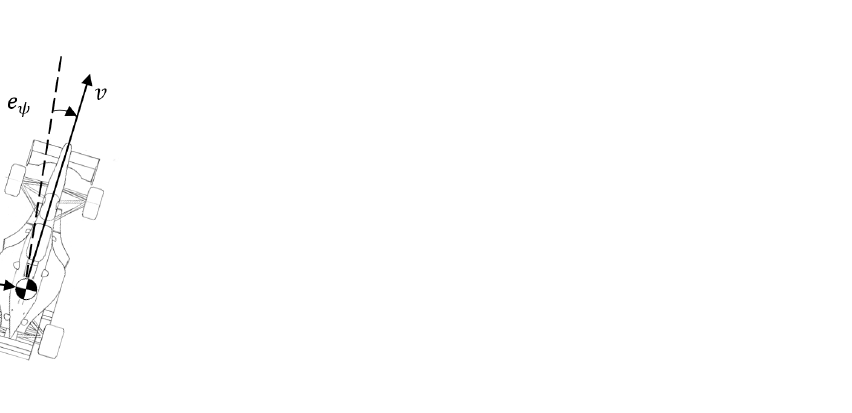
Figure 5. Position error e y and heading error e ψ in a path-following vehicle. The vehicle reference point is represented as the CG, but another location could also be